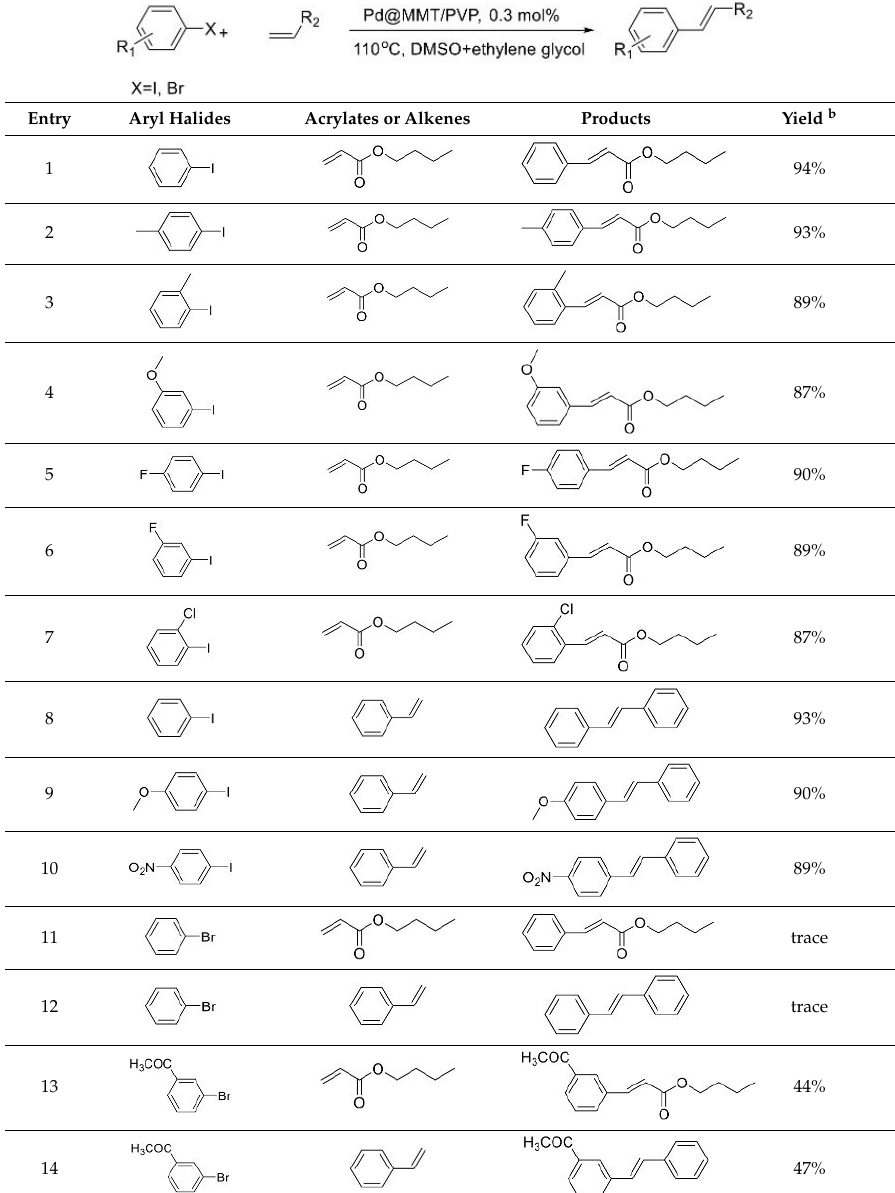
Table 2. Heck reactions between aryl halides and acrylates or alkenes catalyzed with Pd@MMT/PVP catalysts.